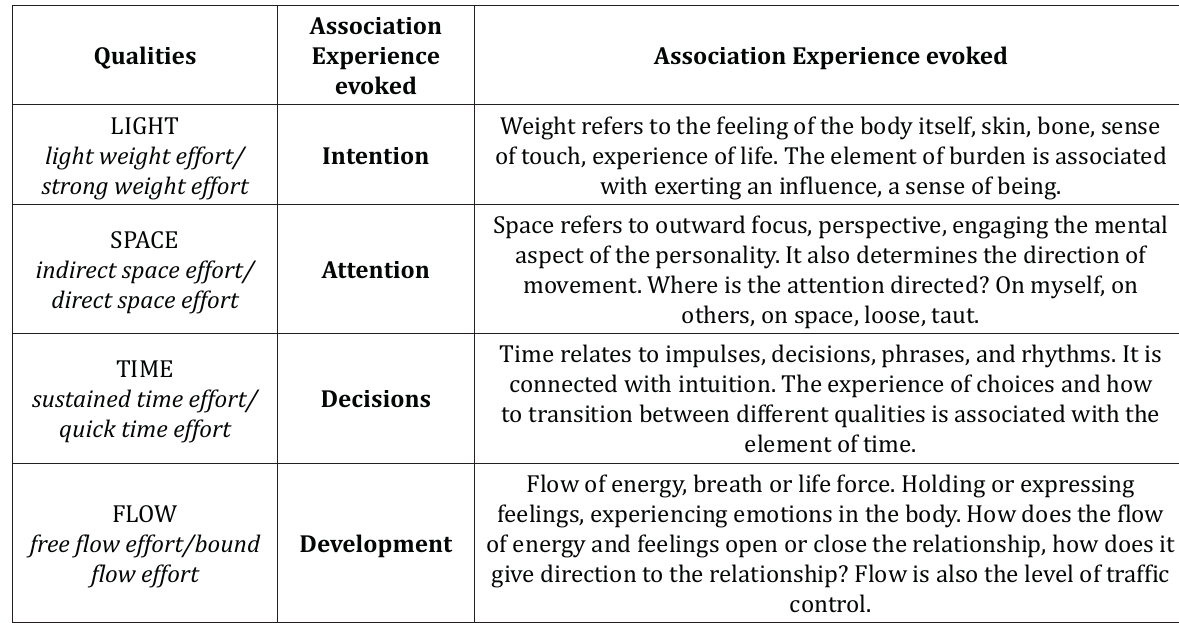
Table 6. Basic elements of dynamic Effort qualities [6]